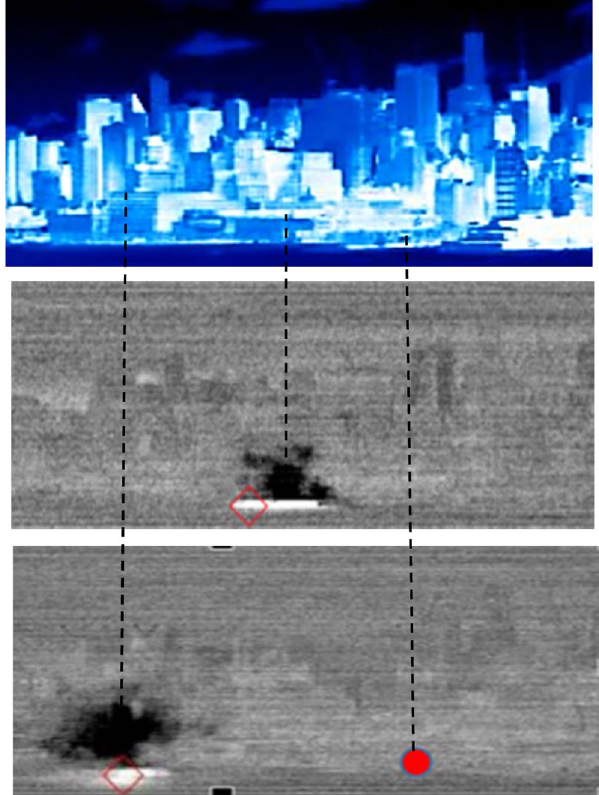
Figure 4. Controlled release test using a canister of DustOff. The upper portion shows false-color depiction of the scene corresponding to measured radiance at 8.2 µ m. The lower images show the matched filter intensity profile of the plumes (obtained using HyperSEA software (Aerospace Corp) traveling at average velocity of 8.6 kph at 65 m and 145 m from the point of release, shown by red circle. Red diamonds point to the pixel with maximum signal, which in this case is the thermal reflection of the plume on the